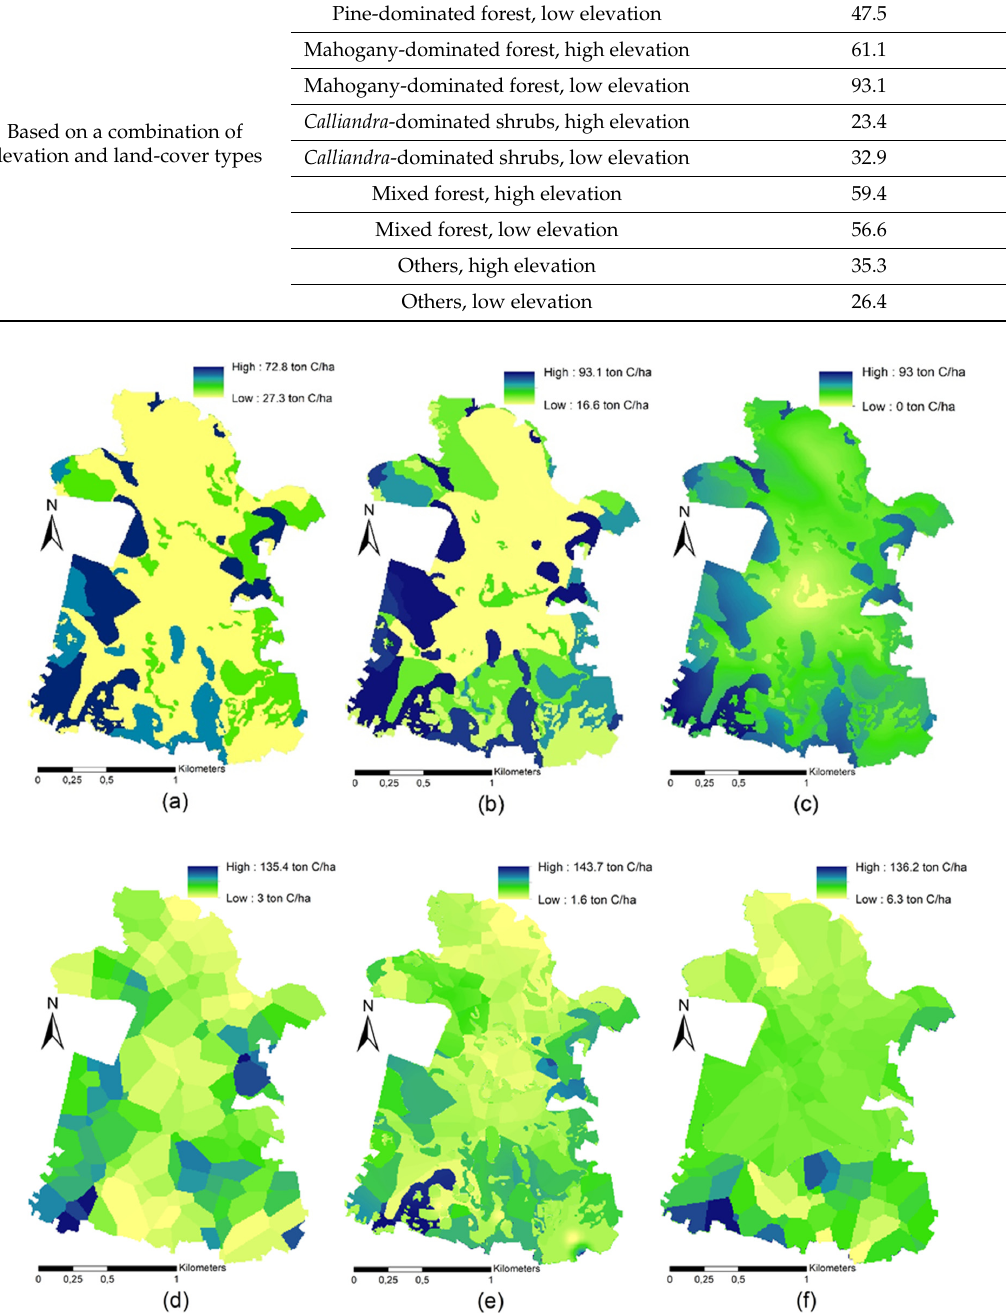
Figure 3. Maps of aboveground carbon in the Geulis Mountain forest generated from the following. ( a ) Lookup table based on land-cover type; ( b ) Lookup table based on a combination of land cover and elevation; ( c ) Regression modeling; ( d ) Geostatistical interpolation without stratification; ( e ) Stratified geostatistical interpolation based on land-cover type; ( f ) Stratified geostatistical interpolation based on elevation.